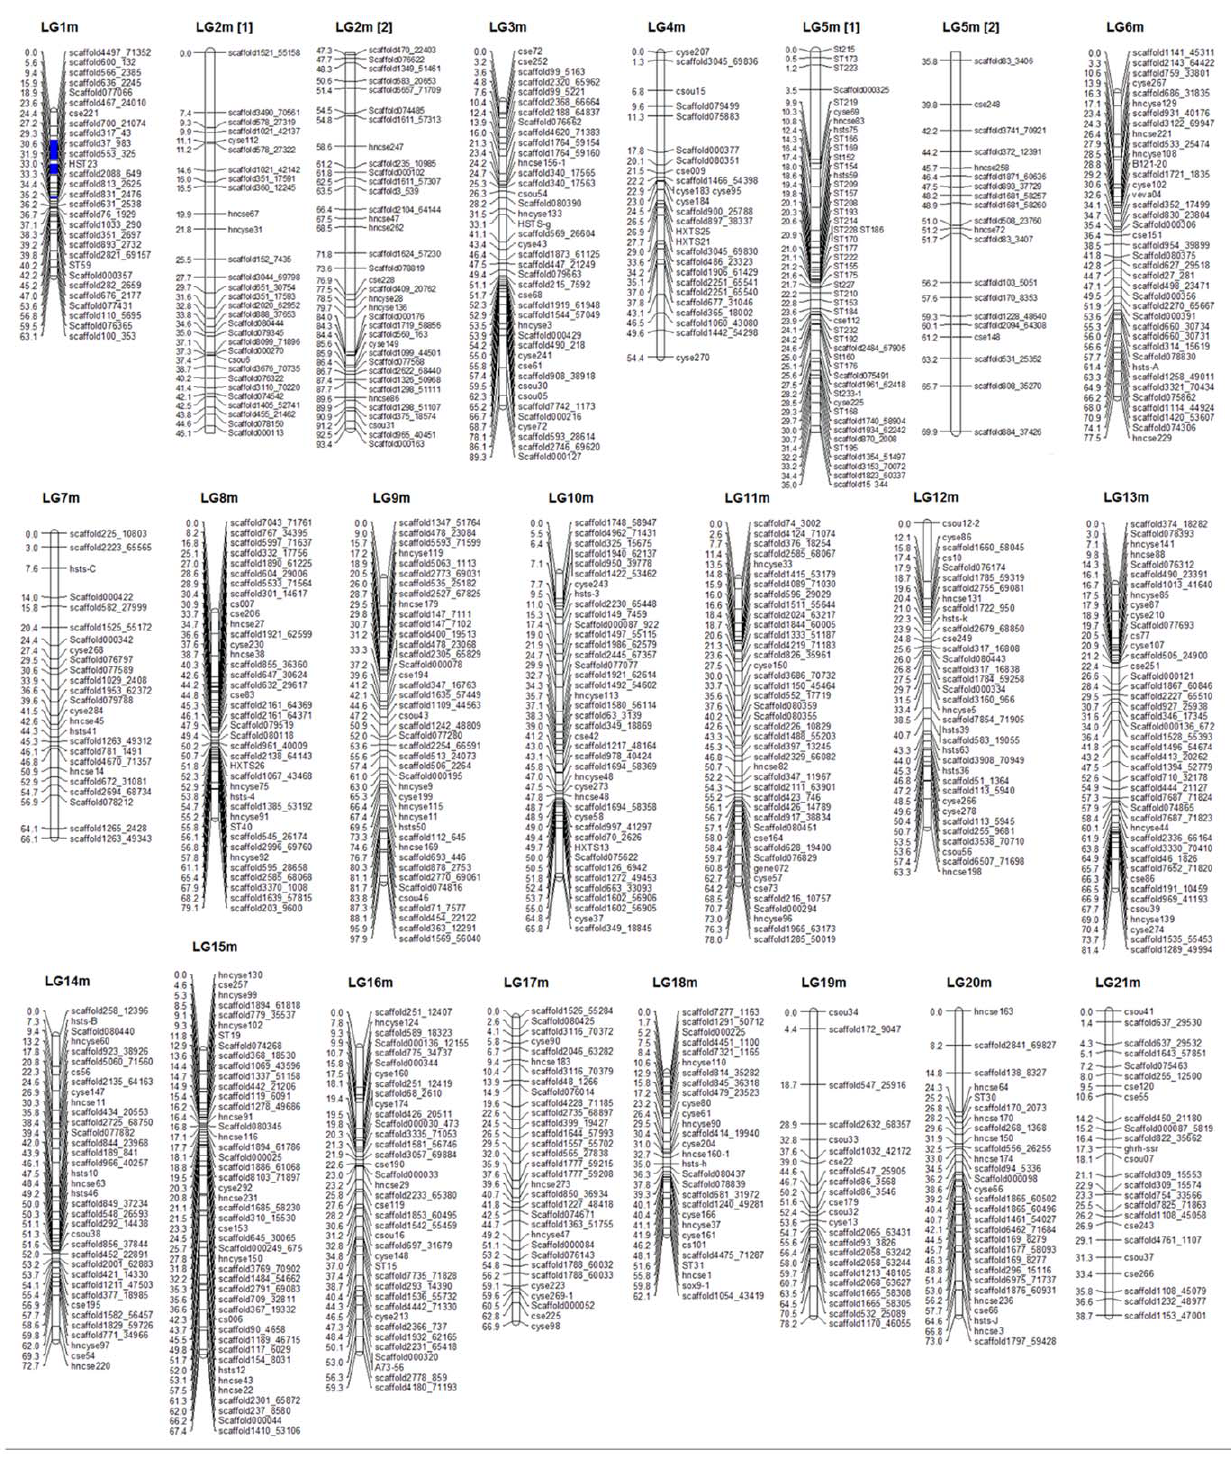
Figure 3. Linkage maps of the male-specific map for Cynoglossussemilaevis . The male-specific genetic map comprises 794 markers assigned to 21 linkage groups (LG1m–LG21m). Genetic distances in Kosambi centimorgans are listed on the left side of the linkage groups, and markers are listed on the right side of the linkage groups. doi:10.1371/journal.pone.0052097.g003 markers will serve as an important tool for future comparative small (doublet or triplet) linkage groups, indicating that this linkage map studies and to establish the underlying correspondence with map is complete. Only 29 of the 1317 markers studied remained unlinked to any other markers. This degree of completeness the linkage groups of other closely related species. There were no